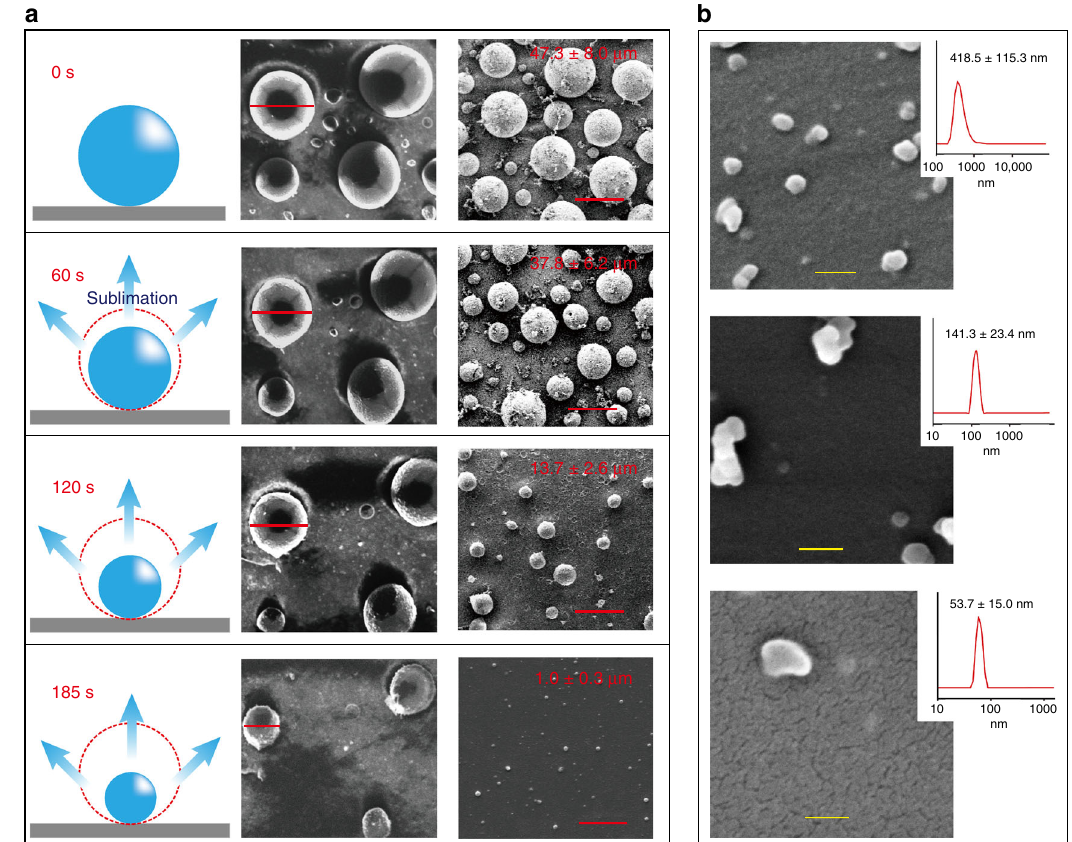
Fig. 2 Control of particle size. a Illustrations of the stage-wise sublimation/deposition process on the left demonstrate the sublimating ice particles and the shrinking volume with respect to the elapsed time. The volume decrease in the ice particles was con fi rmed by the Cryo-SEM images recorded at the corresponding time shown in the middle column (images were captured at the same location for the same sample, scale bars: 50 μ m, 40 μ m, 14.5 μ m, 1 μ m from top down). SEM images of the fabricated polychloro- para -xylylene particles with the corresponding size (values represent the mean ± S.D. of six independent measurements) were shown on the right column (samples were prepared separately, scale bars: 50 μ m). b SEM images and DLS analysis (top insets) of the polychloro- para -xylylene particles produced below submicron range for 418.5 ± 115.3 nm (scale bar: 1 μ m), 141.3 ± 23.4 nm (scale bar: 150 nm), and 53.7 ± 15.0 nm (scale bar: 50 nm)